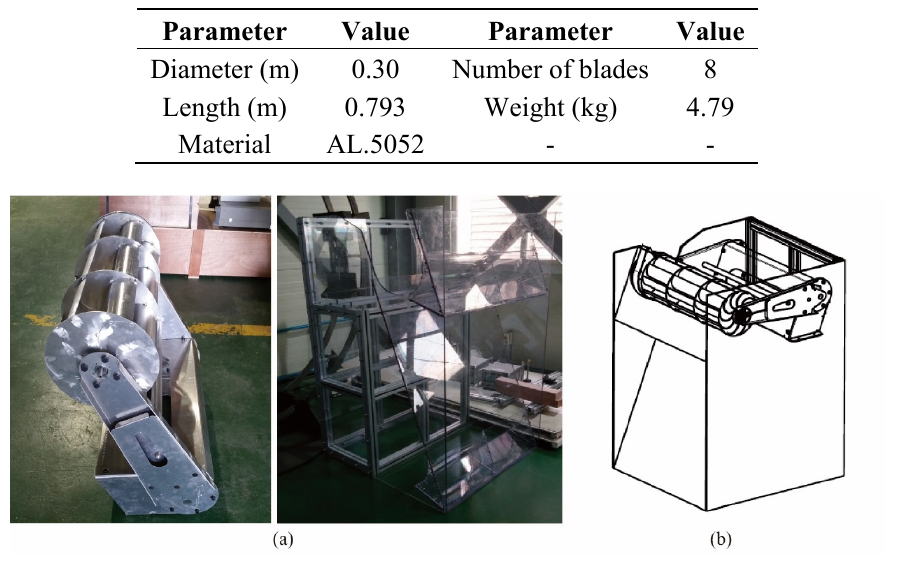
Table 4. Parameters of the rotor.